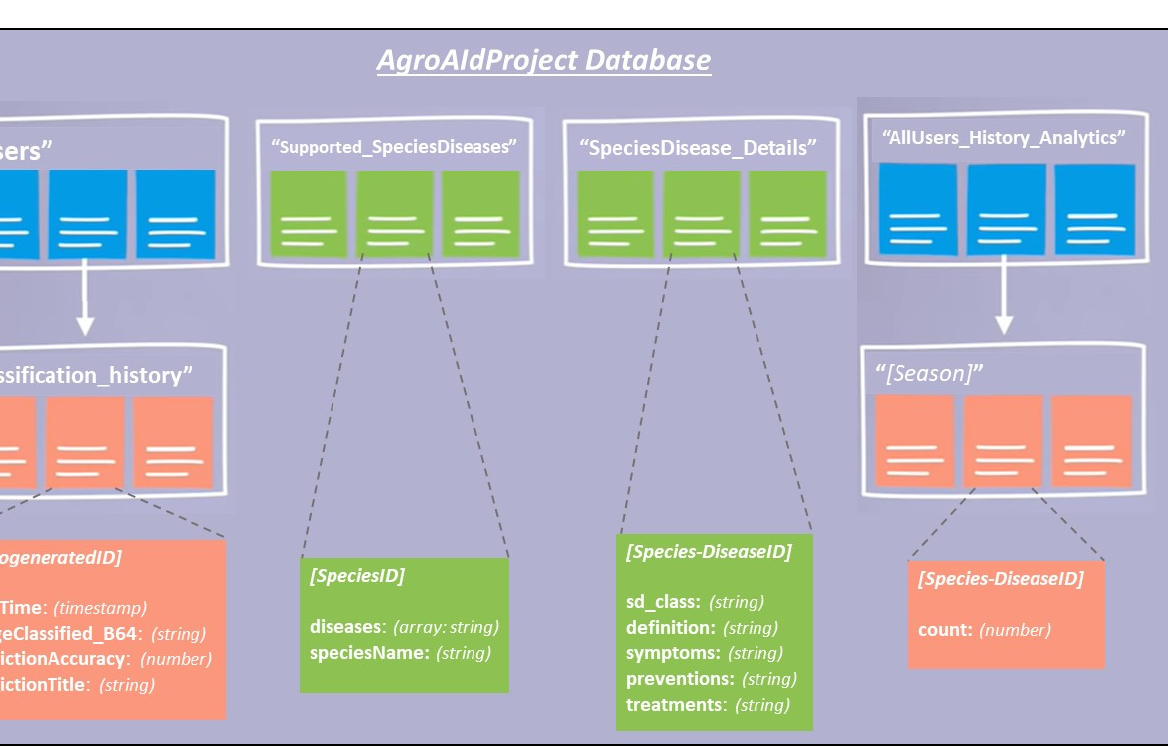
Figure 33. Visualization of the Firestore database schema used for this project.